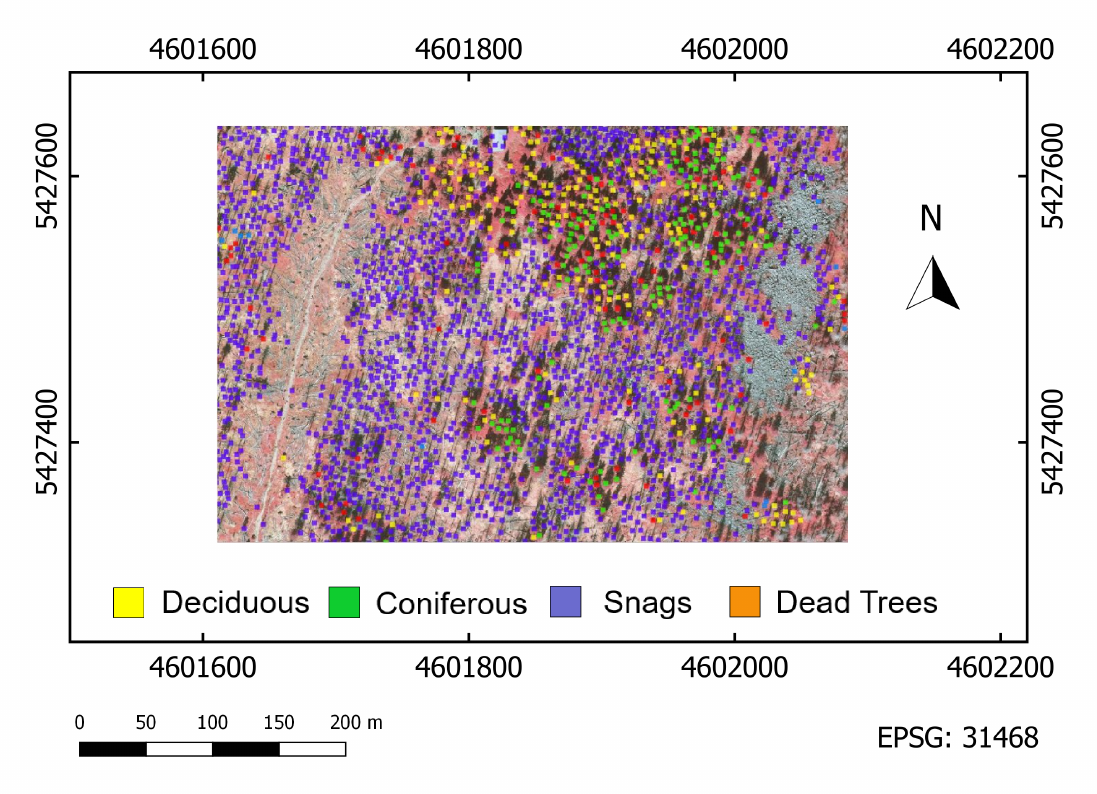
Figure 8. Mapping of conifers, broadleaf trees, dead trees, and snags superimposed with orthophoto. Image source is from Bavarian Forest National